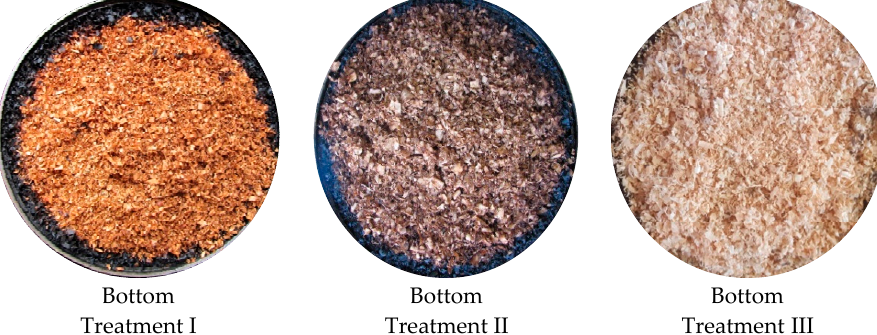
Figure 7. Top and bottom sections of the filter for three treatments: ( I ) wood shavings filter; ( II ) heat exchanger + wood shavings filter; and ( III ) oil bubbler + wood shavings filter.